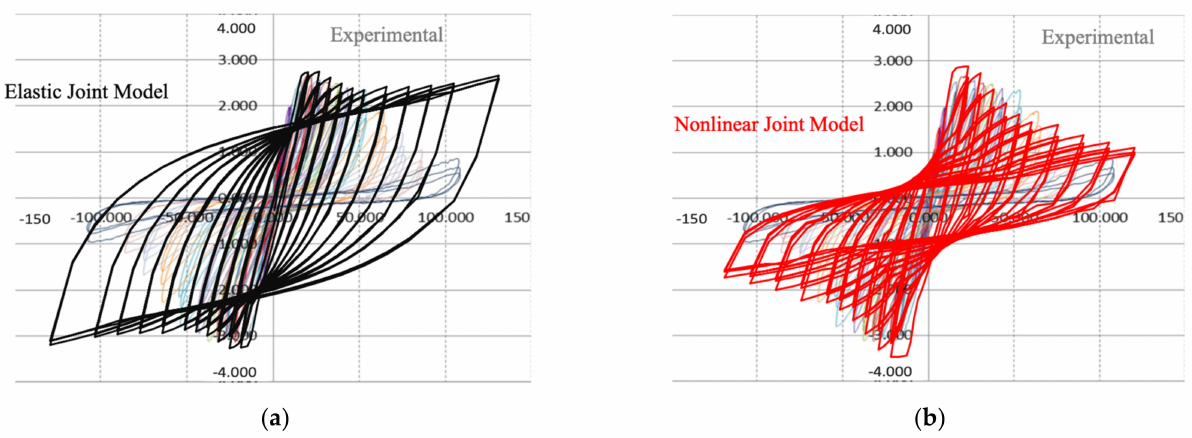
Figure 16. Comparison of the analytical and experimental force–displacement hysteretic responses. A model with elastic joints and conventional beam–column element formulation is shown in ( a ) and a proposed model with nonlinear joints and improved beam–column element formulation is shown in ( b ). Displacement is given in mm, and force is given in